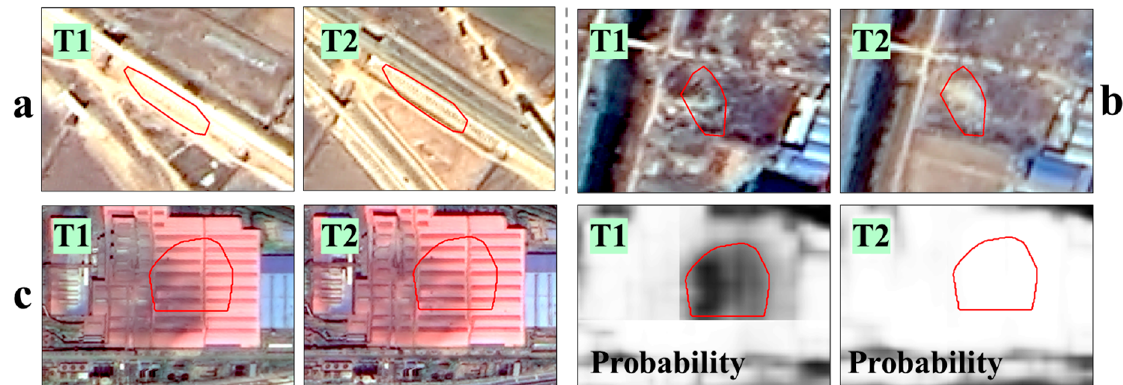
Figure 10. NCBAs failing to meet the rules but scoring greater than 0 by SVM. ( a – c ) represent different examples enumerated. T1 and T2 represent pre-temporal and post-temporal images.